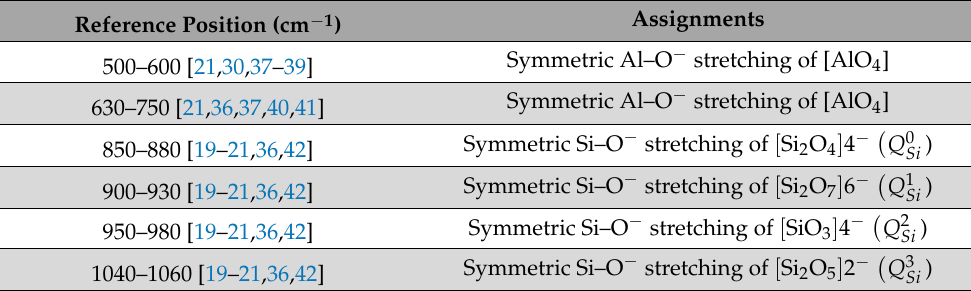
Figure 6. Raman spectra of quenched CaO–SiO 2 –FeO–Al 2 O 3 –MgO slag with 10 wt% initial FeO concentration and varying initial Al 2 O 3 concentrations of ( a ) 10 wt%, ( b ) 20 wt%, and ( c ) 30 wt%. Table 2. Reference Raman peak positions and corresponding assigned aluminate and silicate